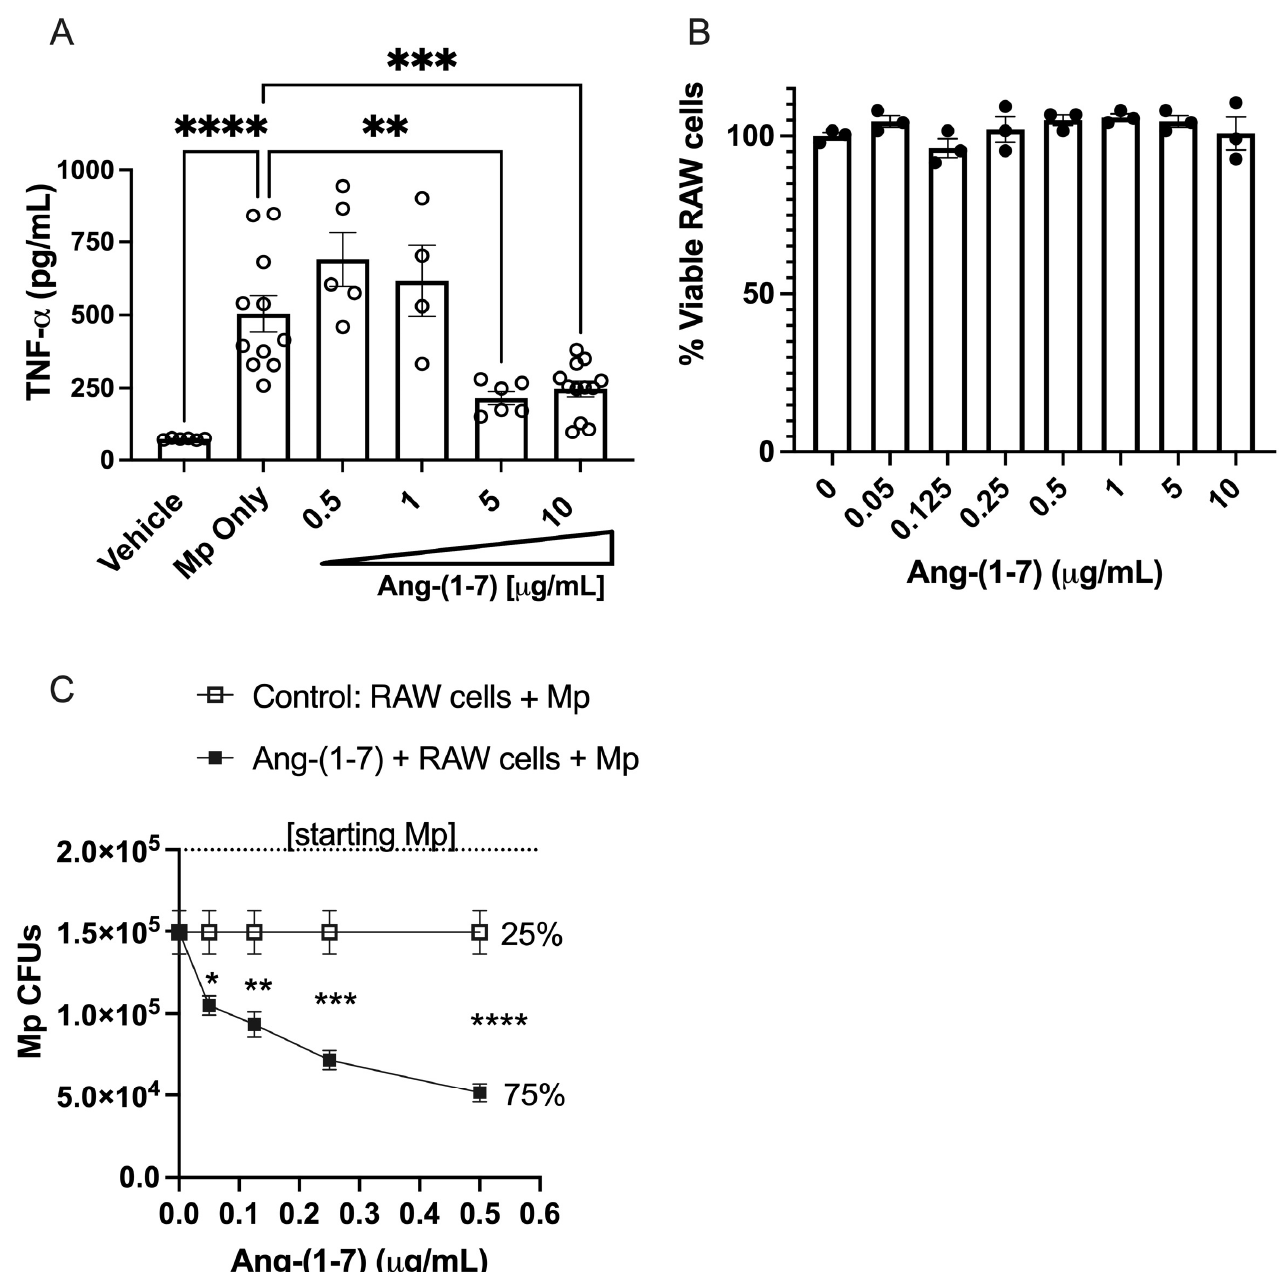
Figure 5. The impact of Ang-(1–7) on macrophage function. ( A ) RAW cells were stimulated with Mp (MOI 10:1) for 4 hours in the presence or absence of increasing doses of Ang-(1-7). Cell-free supernatants were assessed for TNF- α by ELISA. n = minimum of two repeats with triplicates for each. ( B ) RAW cells were incubated with increasing doses of Ang-(1–7) in triplicate for 24 h and viability assessed by Trypan blue exclusion using a Countess cell counter. ( C ) RAW cells were stimulated with Mp (MOI of 2:1) with increasing doses of Ang-(1–7) or vehicle control (saline) for 18 h, after which a sample was taken from each well, diluted 1:100 in SP4 media and plated on PPLO agar plates. CFUs were counted after 2 weeks of growth. n = minimum of two repeats with triplicates for each. * p < 0.05, ** p < 0.01, *** p < 0.001, **** p < 0.0001 by the t-test for each respective dose .